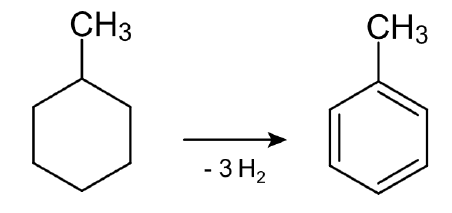
Figure 6 . Dihydrogenation reaction from methylcyclohexane to the aromatic toluene (1-methyl-benzene) for the reversible storage of hydrogen with the aid of the hydrogenation reaction